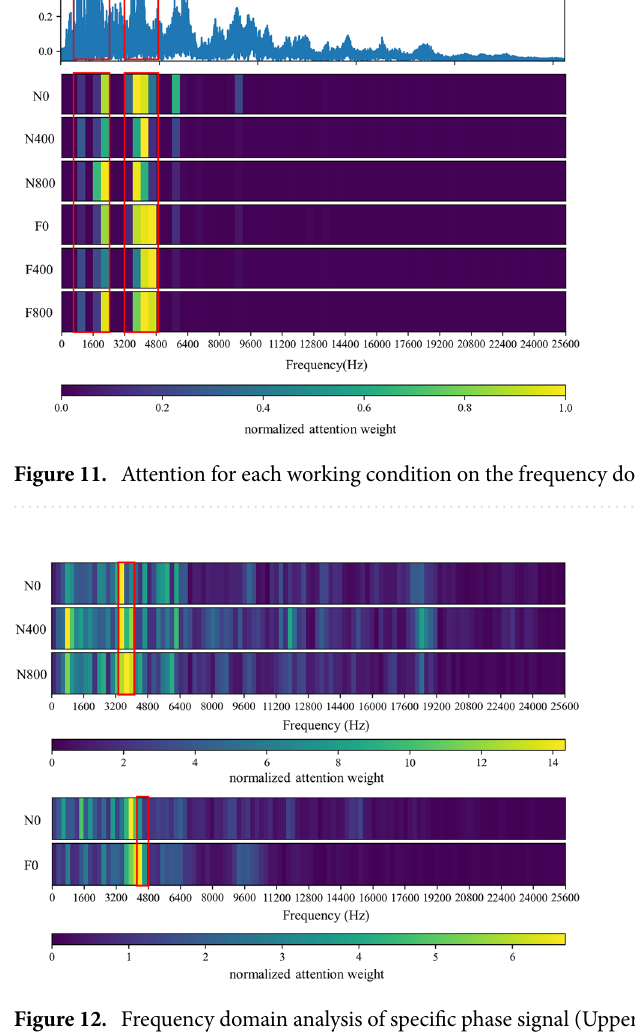
Figure 12. Frequency domain analysis of specific phase signal (Upper: firing; lower: valve